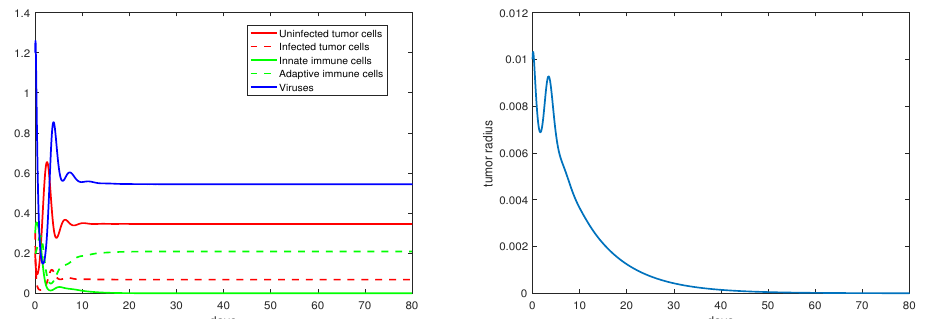
Figure 9. The equilibrium I 2 = ( 0.35,0.08, 0,0.21,0.55 ) is asymptotically stable and the tumor radius is exponentially decreasing when R 0 = 2.33 > R 2 = 1.67. The values of the parameters are: λ = 2, β = 3.5, k 1 = 1, k 2 = 2, s 1 = 20, s 2 = 10, c 1 = 2, c 2 = 1, δ = 10, k 0 = 1.5, γ = 2.5, µ = 2.5, b = 2.